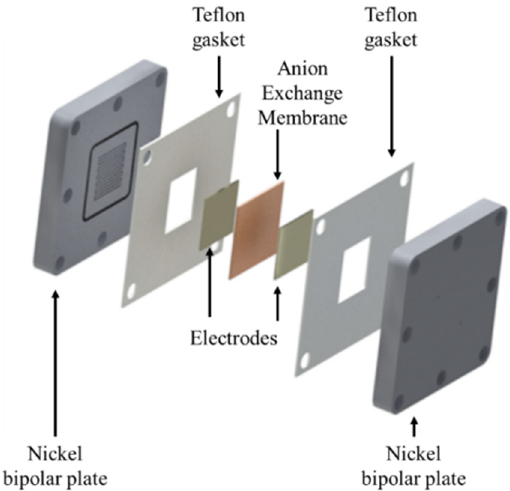
Figure 3. Schematic view of an AEMWE cell assembly and their components.